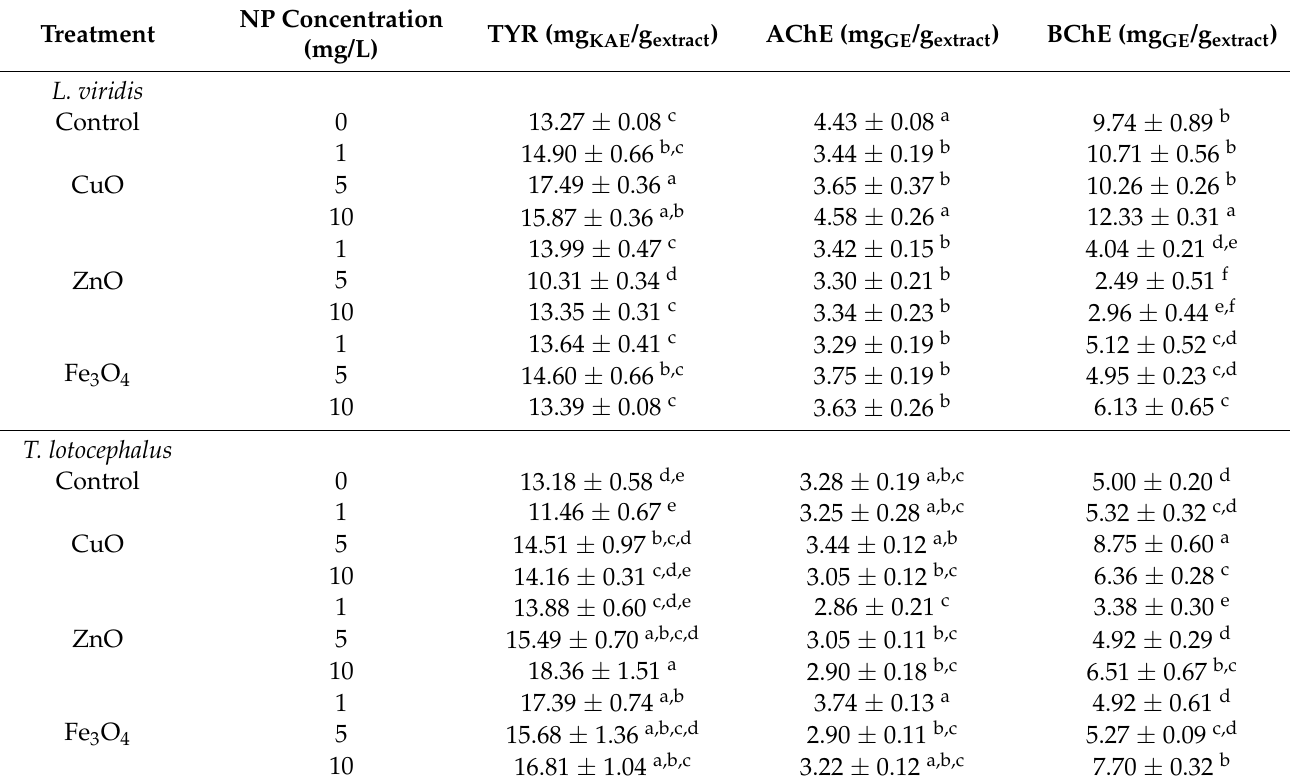
Table 4. Enzymes inhibitory capacity of extracts from Lavandula viridis L’H é r and Thymus lotocephalus L ó pez and Morales shoots cultured in media with 0 (control), 1, 5 or 10 mg/L of CuO, ZnO and Fe 3 O 4 nanoparticles.